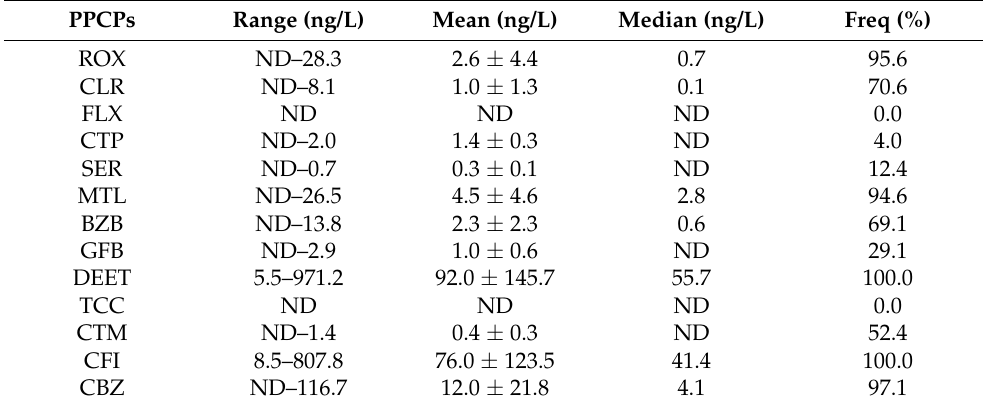
Table 2. Detection frequency and concentration range of PPCPs in the river water.